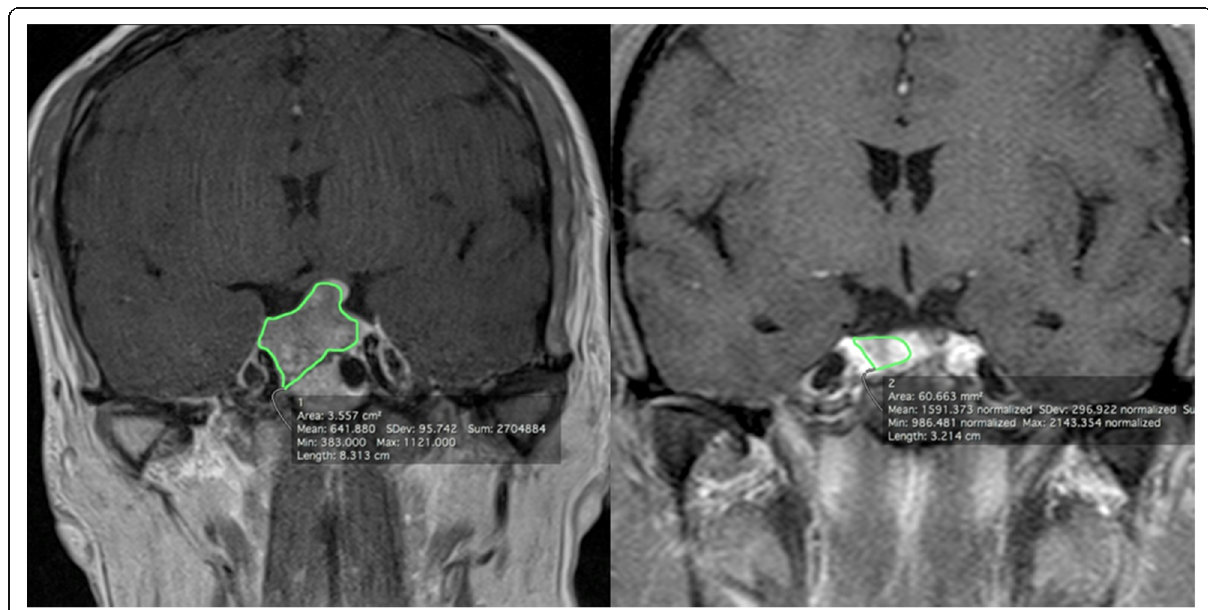
Fig. 1 A coronal contrasted T1-weighted MR image for a pre-operative tumor with a volume 5.92 cc, Knosp grade 1 (left) that was reduced to 0.76 cc (right) after microscopic resection (88% volume